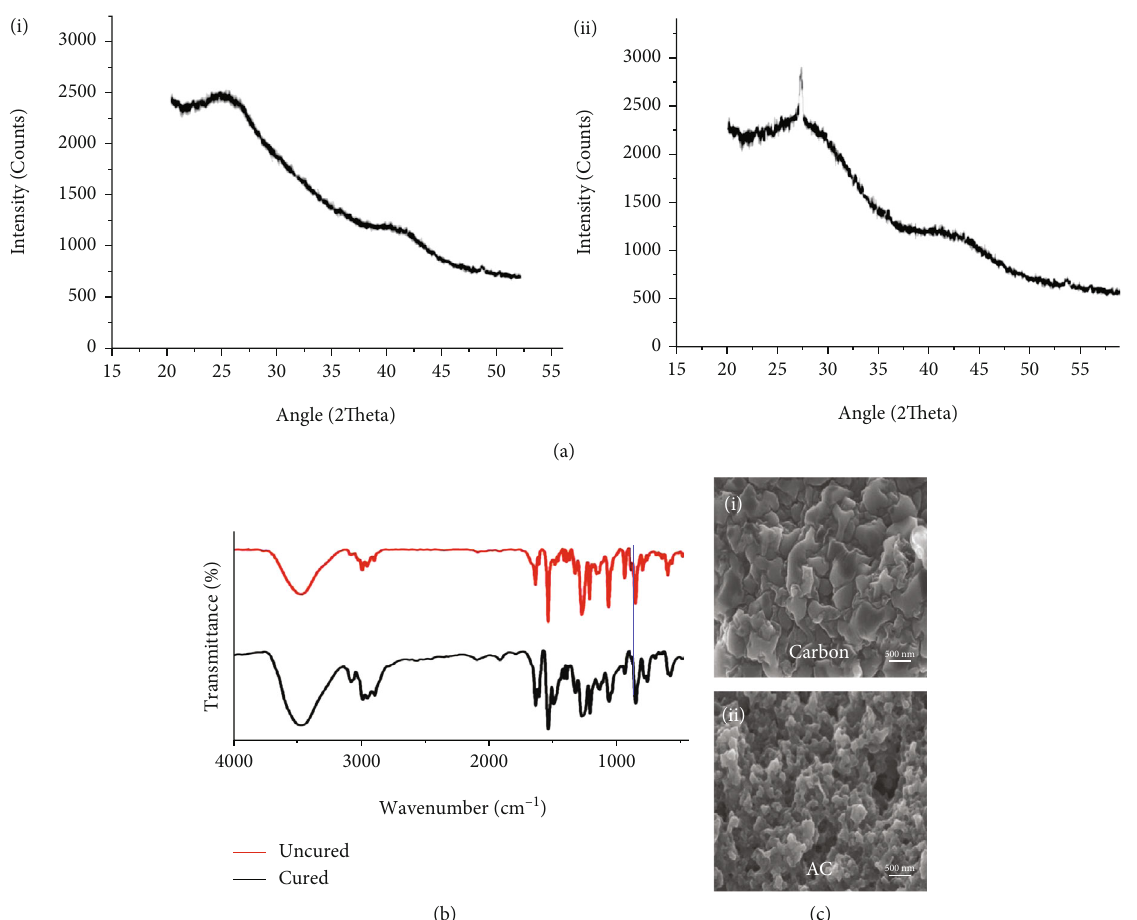
Figure 1: (a) XRD pattern of activated carbon (AC). (b) FT-IR spectra for uncured and cured epoxy. (c) SEM images for biomass-derived (i) carbon and (ii) activated